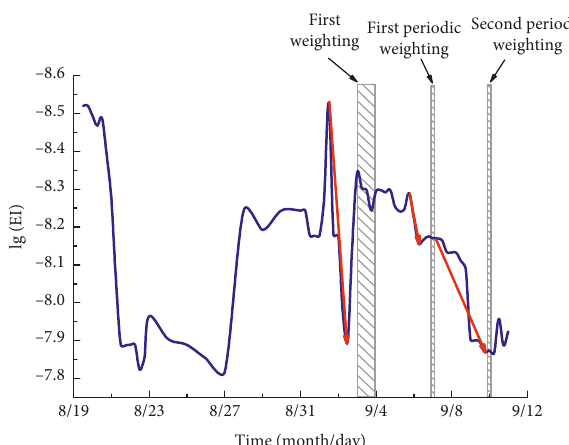
Figure 12: Changes of energy index with time.